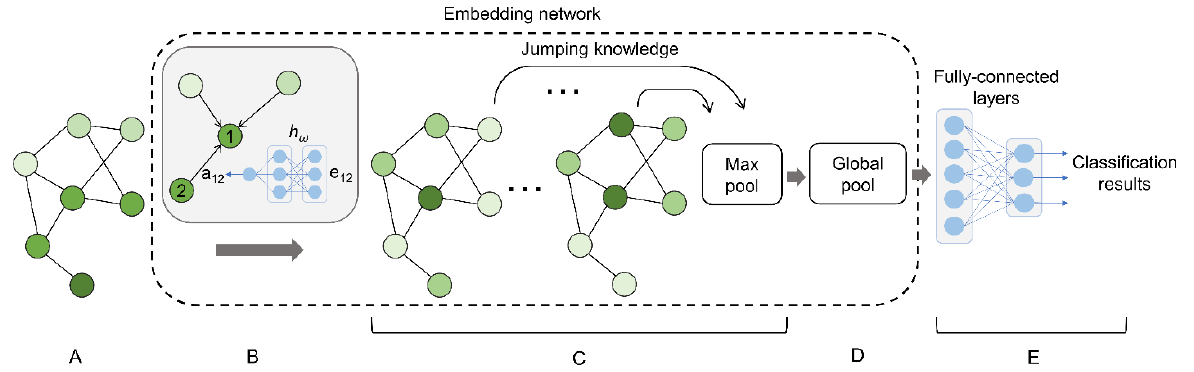
Figure 2. Architecture of the pocket classifier in GraphSite. ( A ) The input graph represents a binding site. ( B ) A neural network computing the weight for message passing from the edge attributes of the input graph. ( C ) Message passing layers of the jumping knowledge network. ( D ) A global pooling layer implementing the Set2Set model. ( E ) Fully connected layers generate the final classification